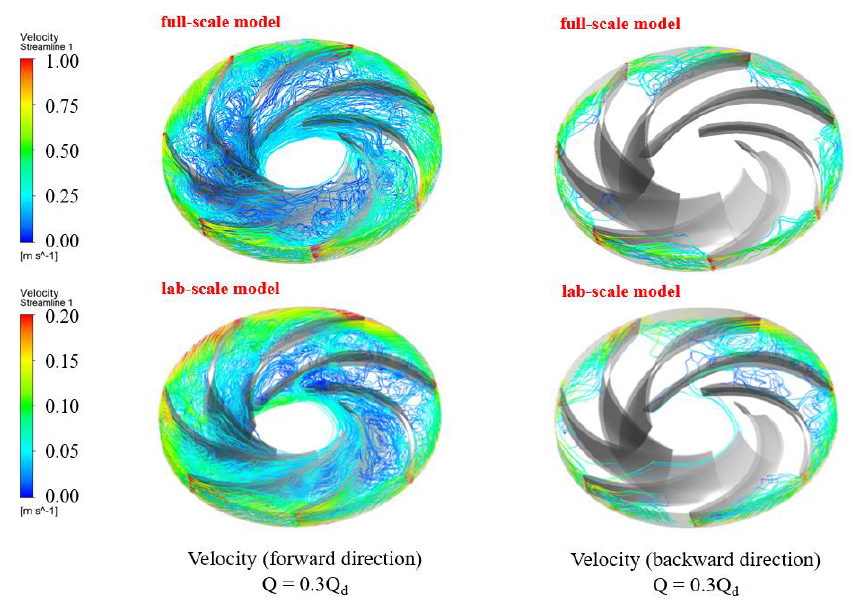
Figure 16. Comparison of the instantaneous velocity streamlines with forward and backward directions in the runner between the models.